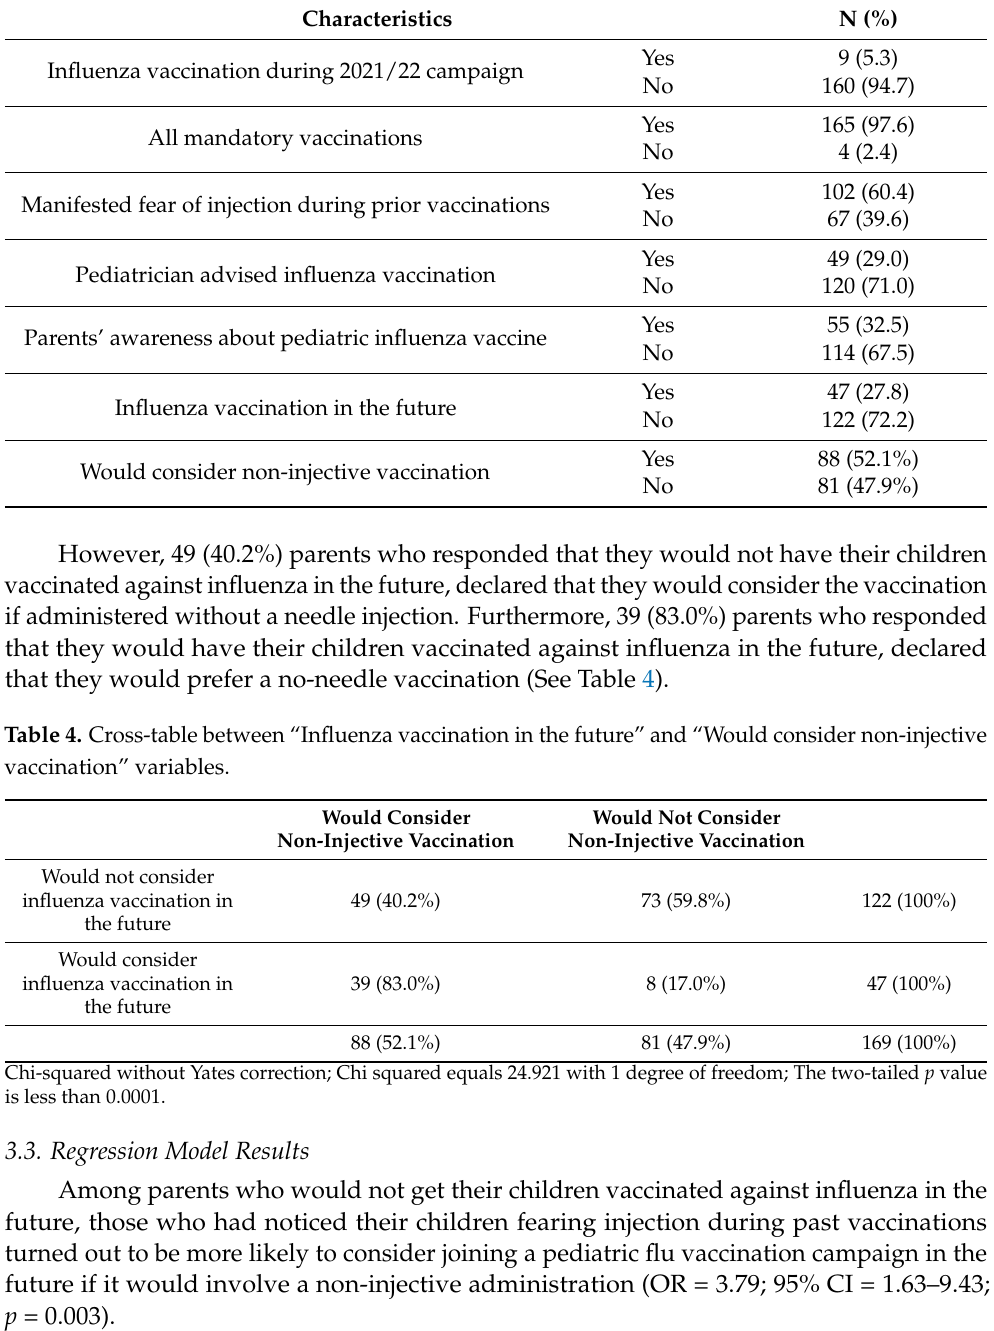
Table 3. Past vaccination experiences and future perspectives.